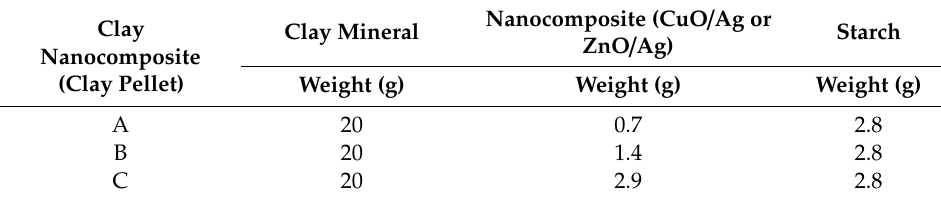
Table 1. Weight of materials used for preparing clay membranes A, B and